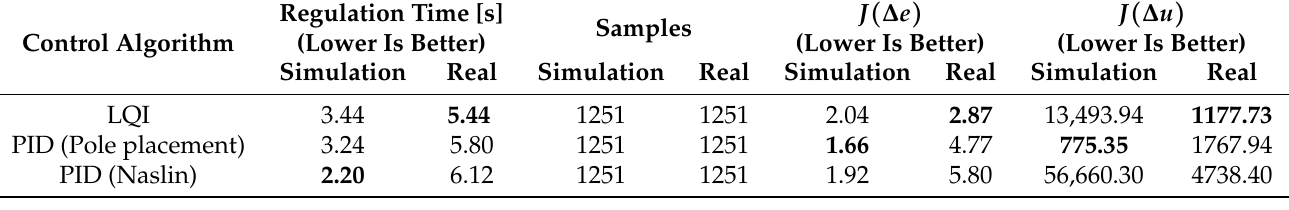
Table 2. Quantitative comparison of various control algorithms on simulation and real plant.